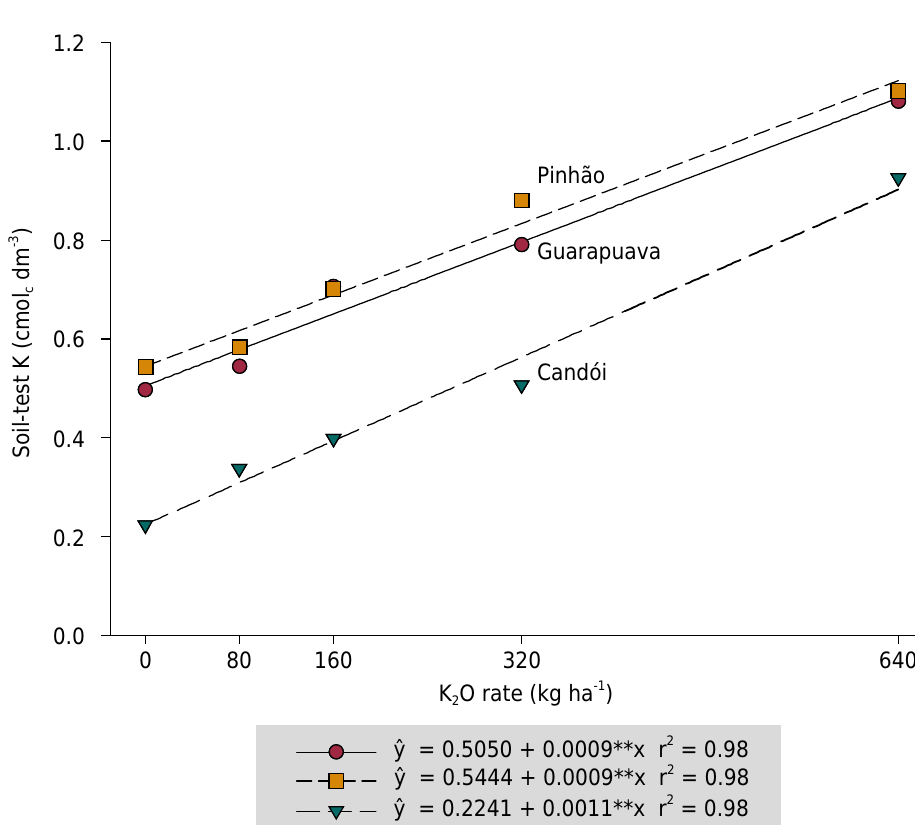
Figure 3. Soil-test K seven months after K 2 O application in Guarapuava, Pinhão, and Candói, PR, Brazil.